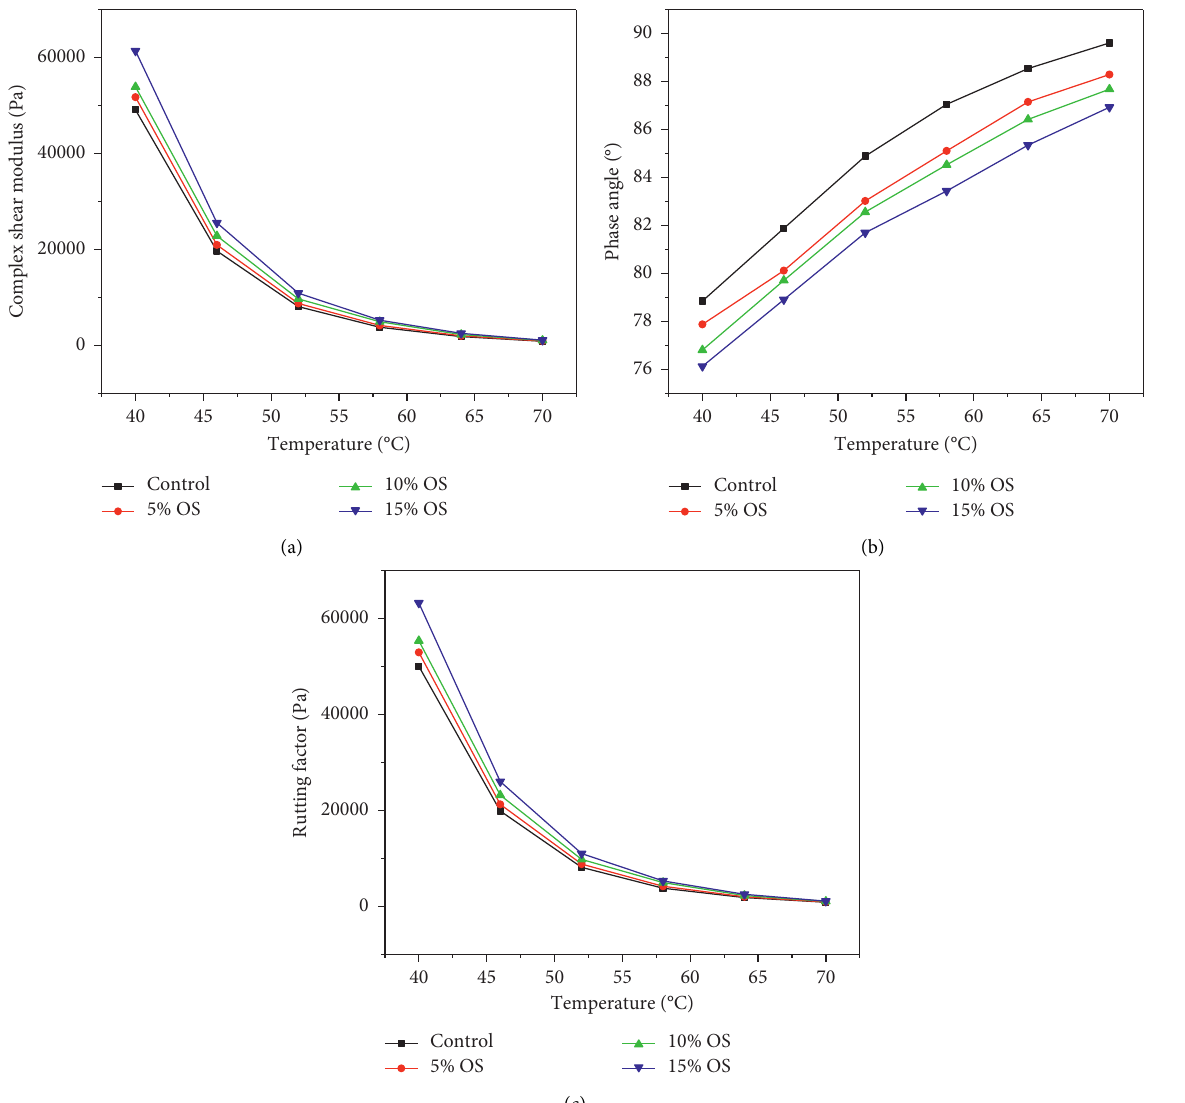
Figure 6: Temperature sweep. (a) | G ∗ | of the studied material during the temperature sweep. (b) δ of the studied material during the temperature sweep. (c) (| G ∗ | /sin δ ) of the studied material during the temperature